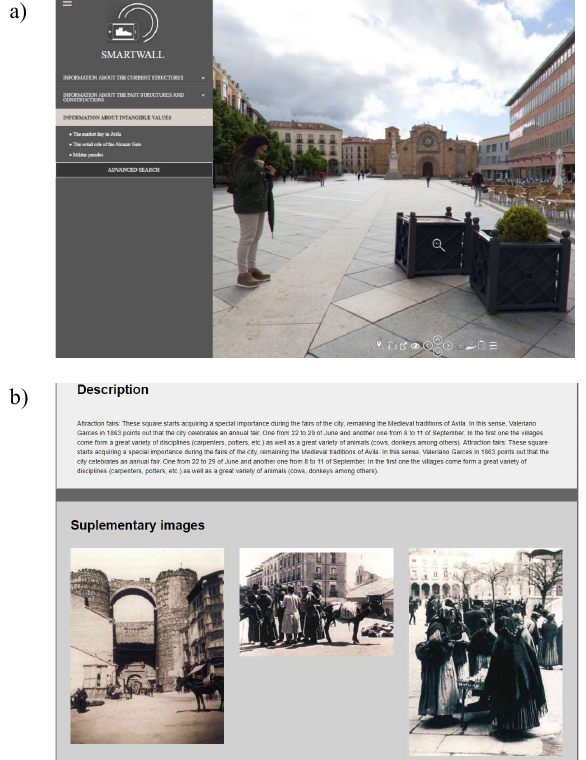
Figure 9. Response of the platform when a tourist wants to consult the information related with the Market day.